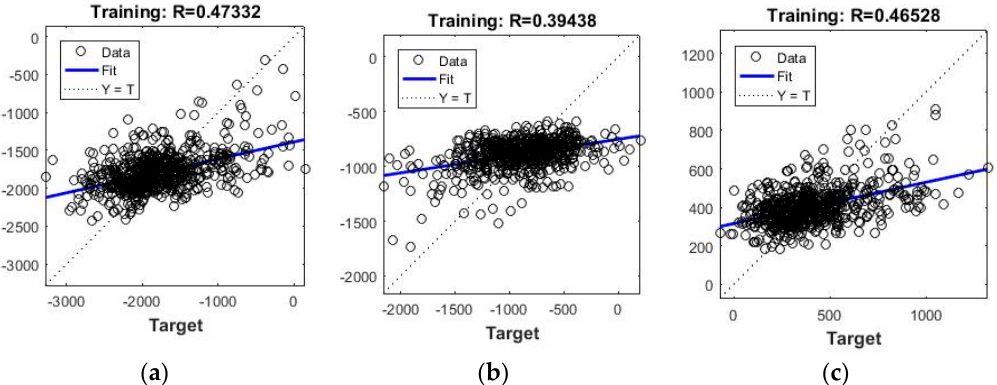
Figure 5. BNN two hidden layers fitting results based on the 85% of the samples: ( a ) REP against GPR slice depth between 0.00–0.20 m; ( b ) REP against GPR slice depth between 0.20–0.40 m; and ( c ) REP against GPR slice depth between 0.40–0.60 m.